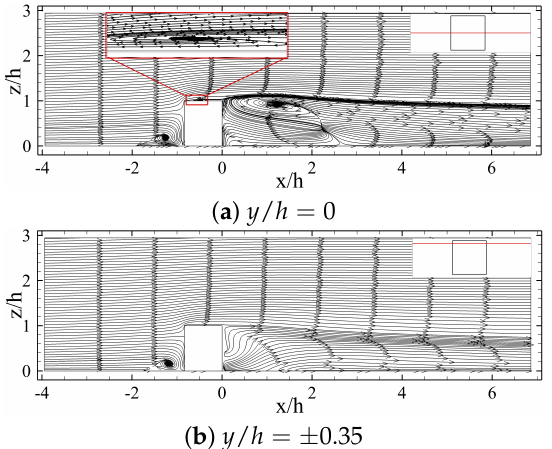
Figure 17. The side ( xz -plane) view of the wake structure of the square